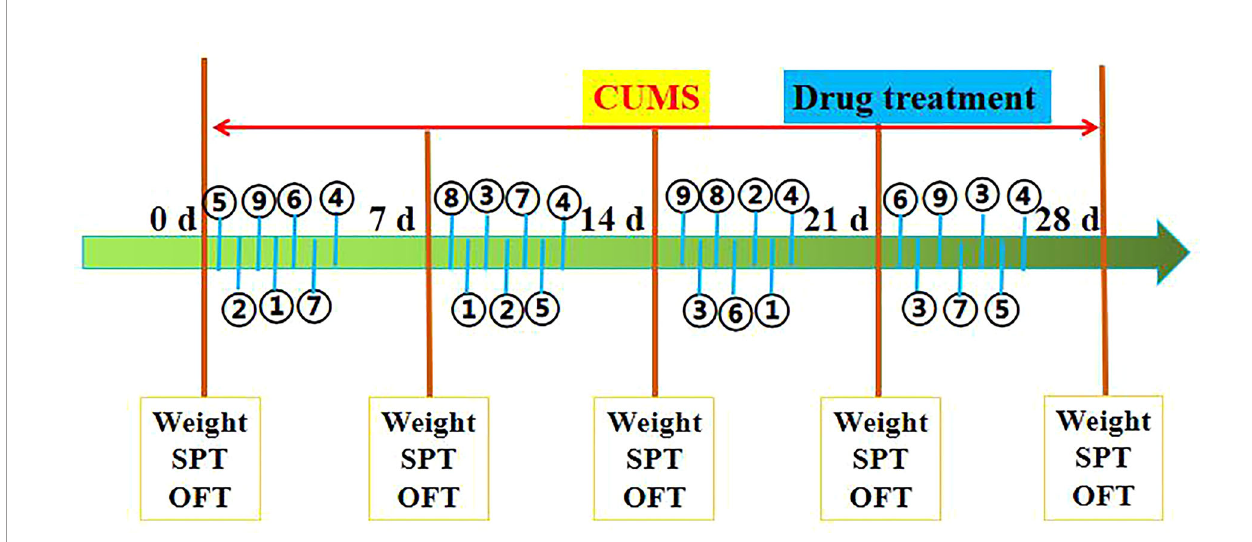
FIGURE 2 | Schematic diagram of the experimental procedure, as described in Materials and Methods . Stimulating factors, including ① tail pinch, ② cold swimming, ③ food deprivation, ④ water deprivation, ⑤ exposure to a hot environment, ⑥ day and night reversal, ⑦ foot shock, ⑧ binding of bottles, and ⑨ ultrasonic stimulation. SPT (sucrose preference), OPT (open fi eld test), and Weight (body weight). The rats were sacri fi ced on 29th